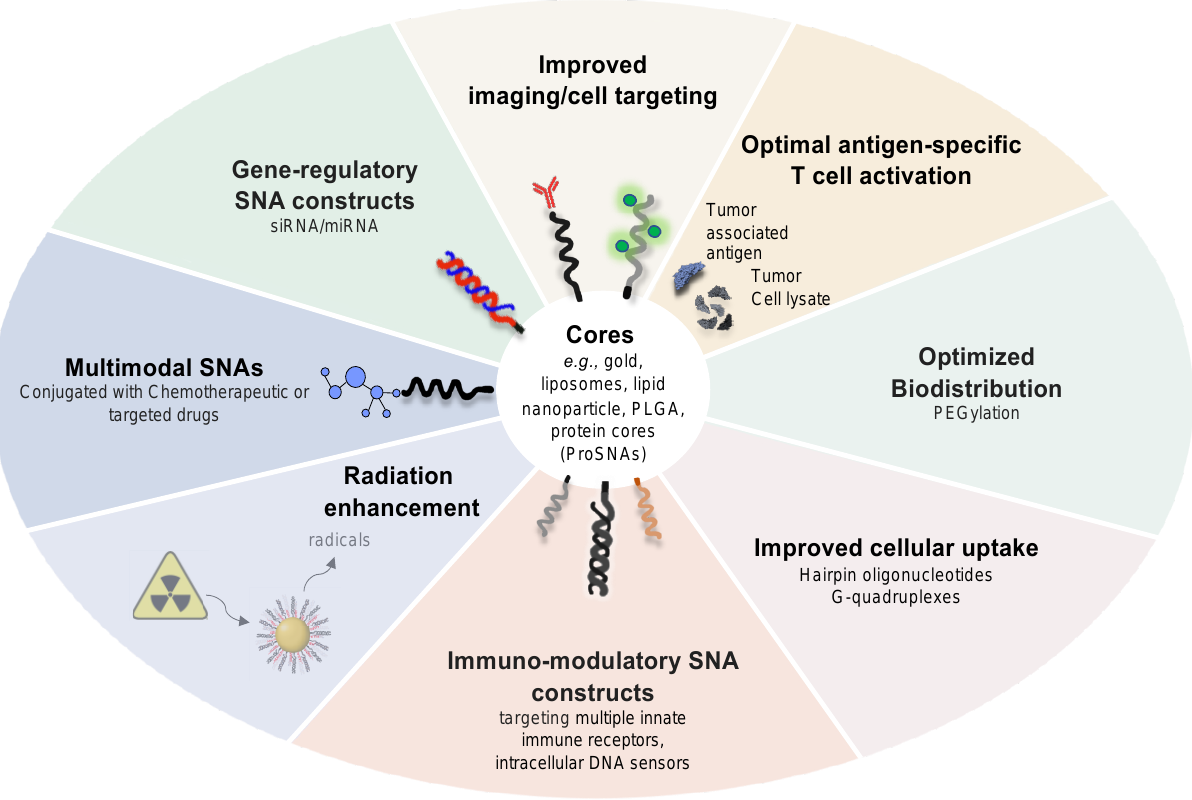
Figure 4. Next-generation SNA architectures for gene regulation and immunostimulation.